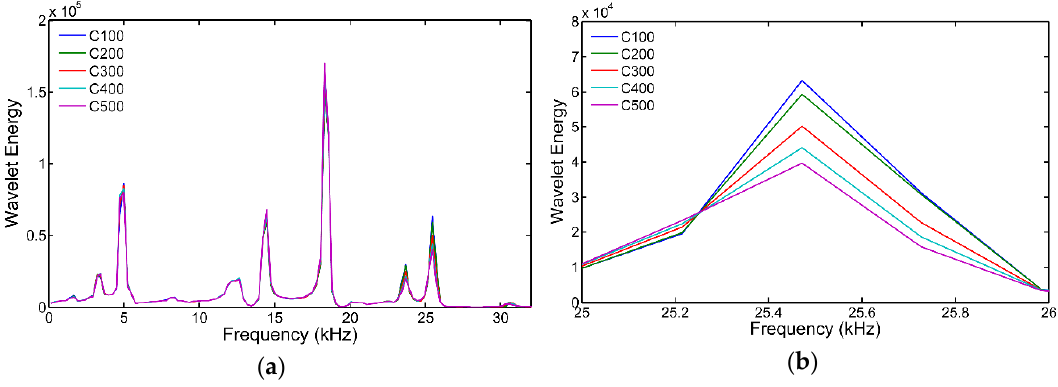
Figure 8. Wavelet energy of one I ‐ section of the ground floor of specimen SD. (a) Complete frequency range; (b) Zoom around the 25 kHz natural frequency.